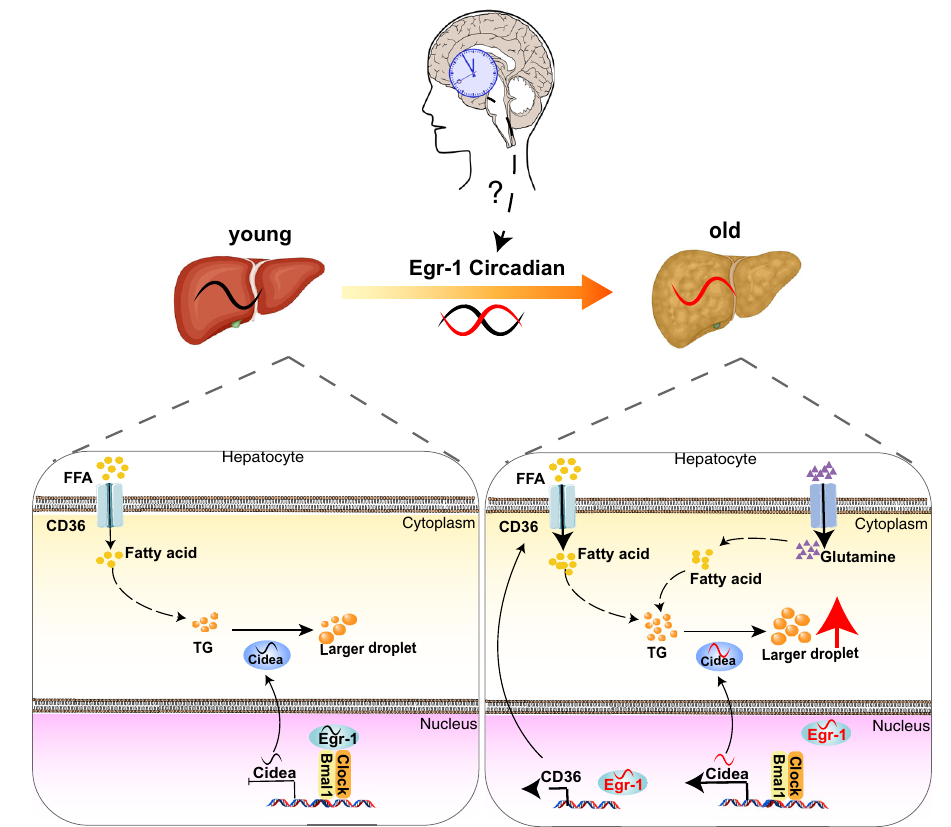
Fig. 8 | Schematic for the contribution of Egr-1 rhythm to the correlation between circadian rhythms and metabolic patterns with age increased. At a young age, Egr-1 combines with circadian genes BMAL1/CLOCK to form a complex, then regulates the circadian expression of Cidea to maintain the balance of lipid metabolism.Withage increased, Egr-1 rhythm alteration might resultinuncouplingofEgr-1withbothcircadiangenesBMAL1/CLOCKandlipid metabolic genes Cidea, facilitating the CD36 expression to promote the fatty